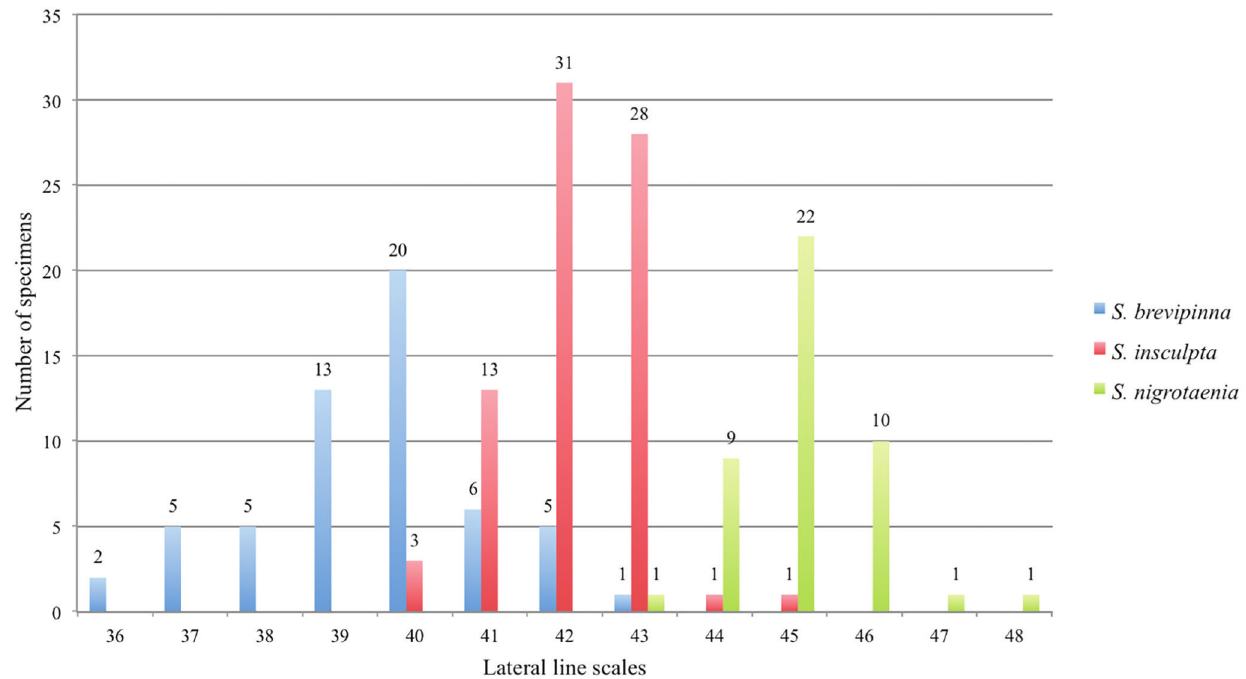
Fig. 3. Histogram of number of lateral-line scales against number of specimens of Steindachnerina brevipinna , S. insculpta and S. nigrotaenia .